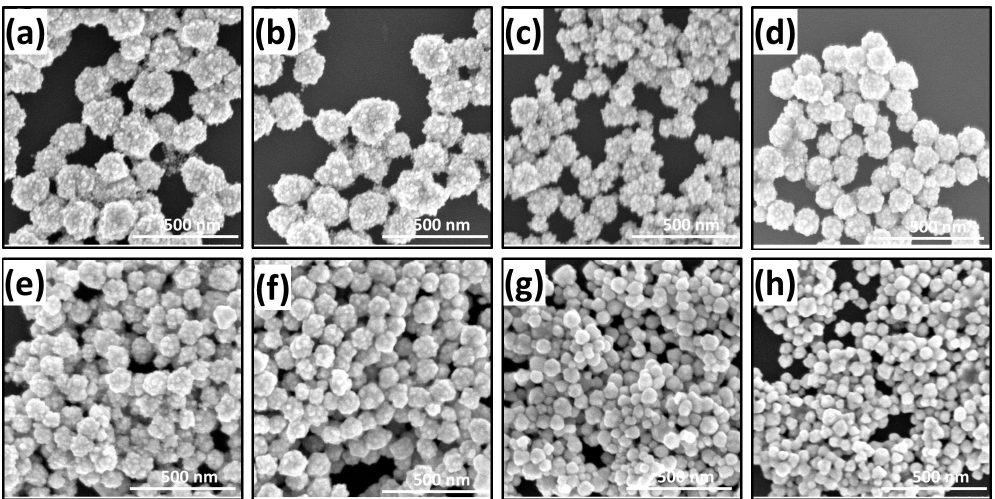
Figure 1. FESEM images of the AuNBr synthesized with different amounts of AA volumes: ( a ) 10 μ L; ( b ) 20 μ L; ( c ) 30 μ L; ( d ) 40 μ L; ( e ) 50 μ L; ( f ) 60 μ L; ( g ) 70 μ L and ( h ) 80 μ L. Table 1. The detailed structural parameters of the synthesized AuNBr measured from TEM images (see Figure S1 in